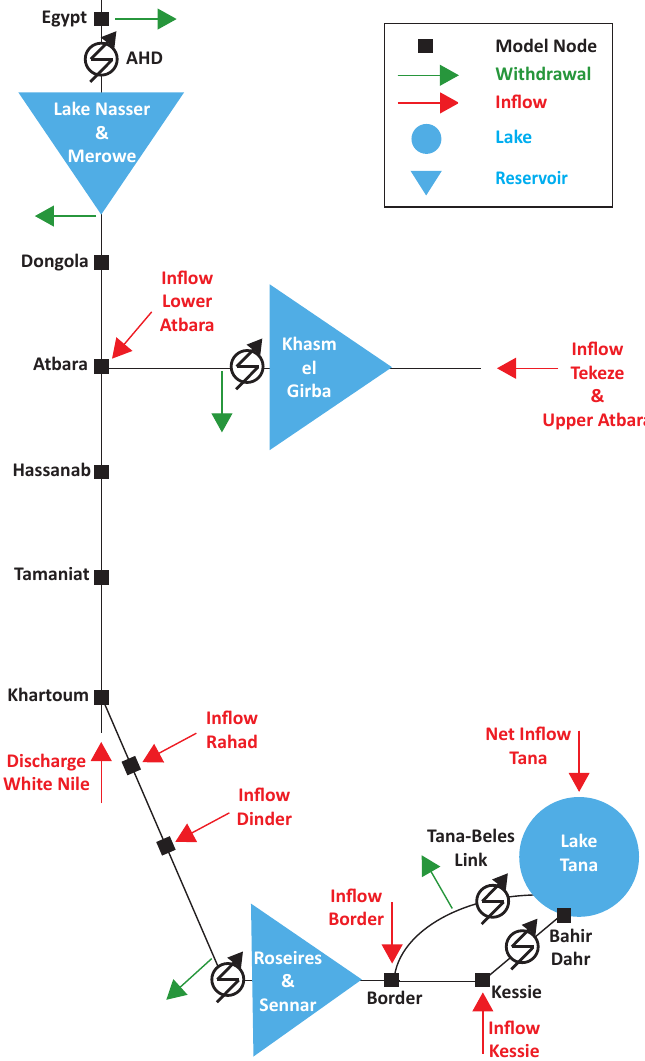
Figure 3. Schematic representation of the Nile River system. White Nile upstream Khartoum and Atbara before Khasm el Girba Dam have been considered as unregulated